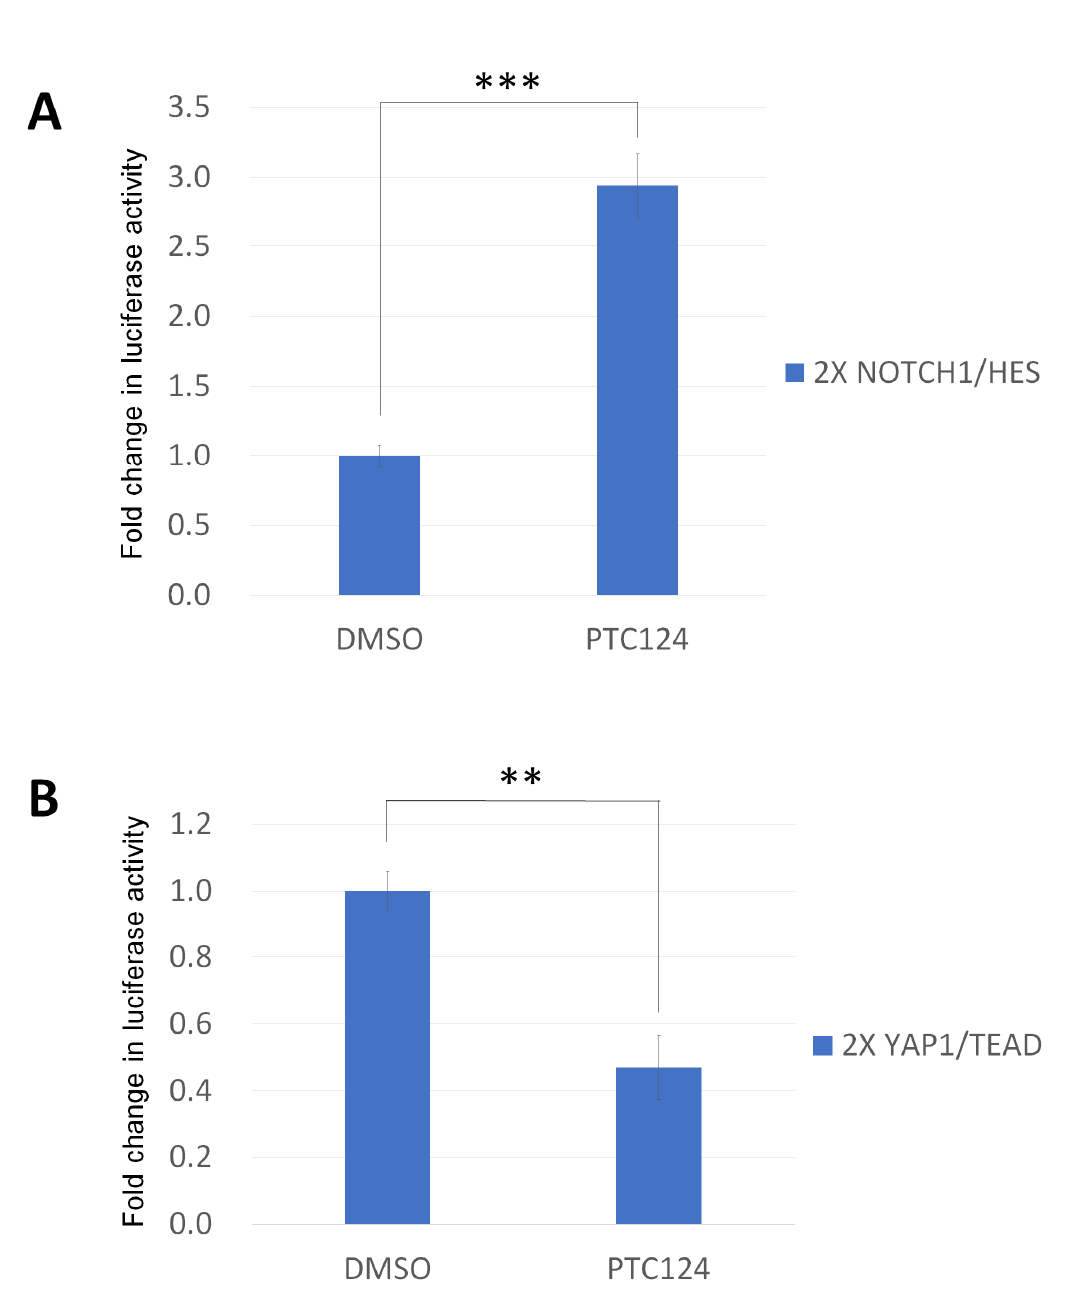
Figure 4. PTC124 can moderate HES and TEAD transactivation function. ( A ) PTC124 (50 µ M) can upregulate 2X NOTCH1 /HES consensus sequence reporter assay in DOK cells (*** p < 0.001). DMSO only was calculated as 1 to normalize for the other conditions. The results are displayed as mean ± SD, n = 3. ( B ) PTC124 (50 µ M) can downregulate 2X YAP1/TEAD consensus sequence reporter assay in HO-1-u-1 cells (** p < 0.01). DMSO only was calculated as 1 to normalize for the other conditions. Results are displayed as mean ± SD, n = 3.